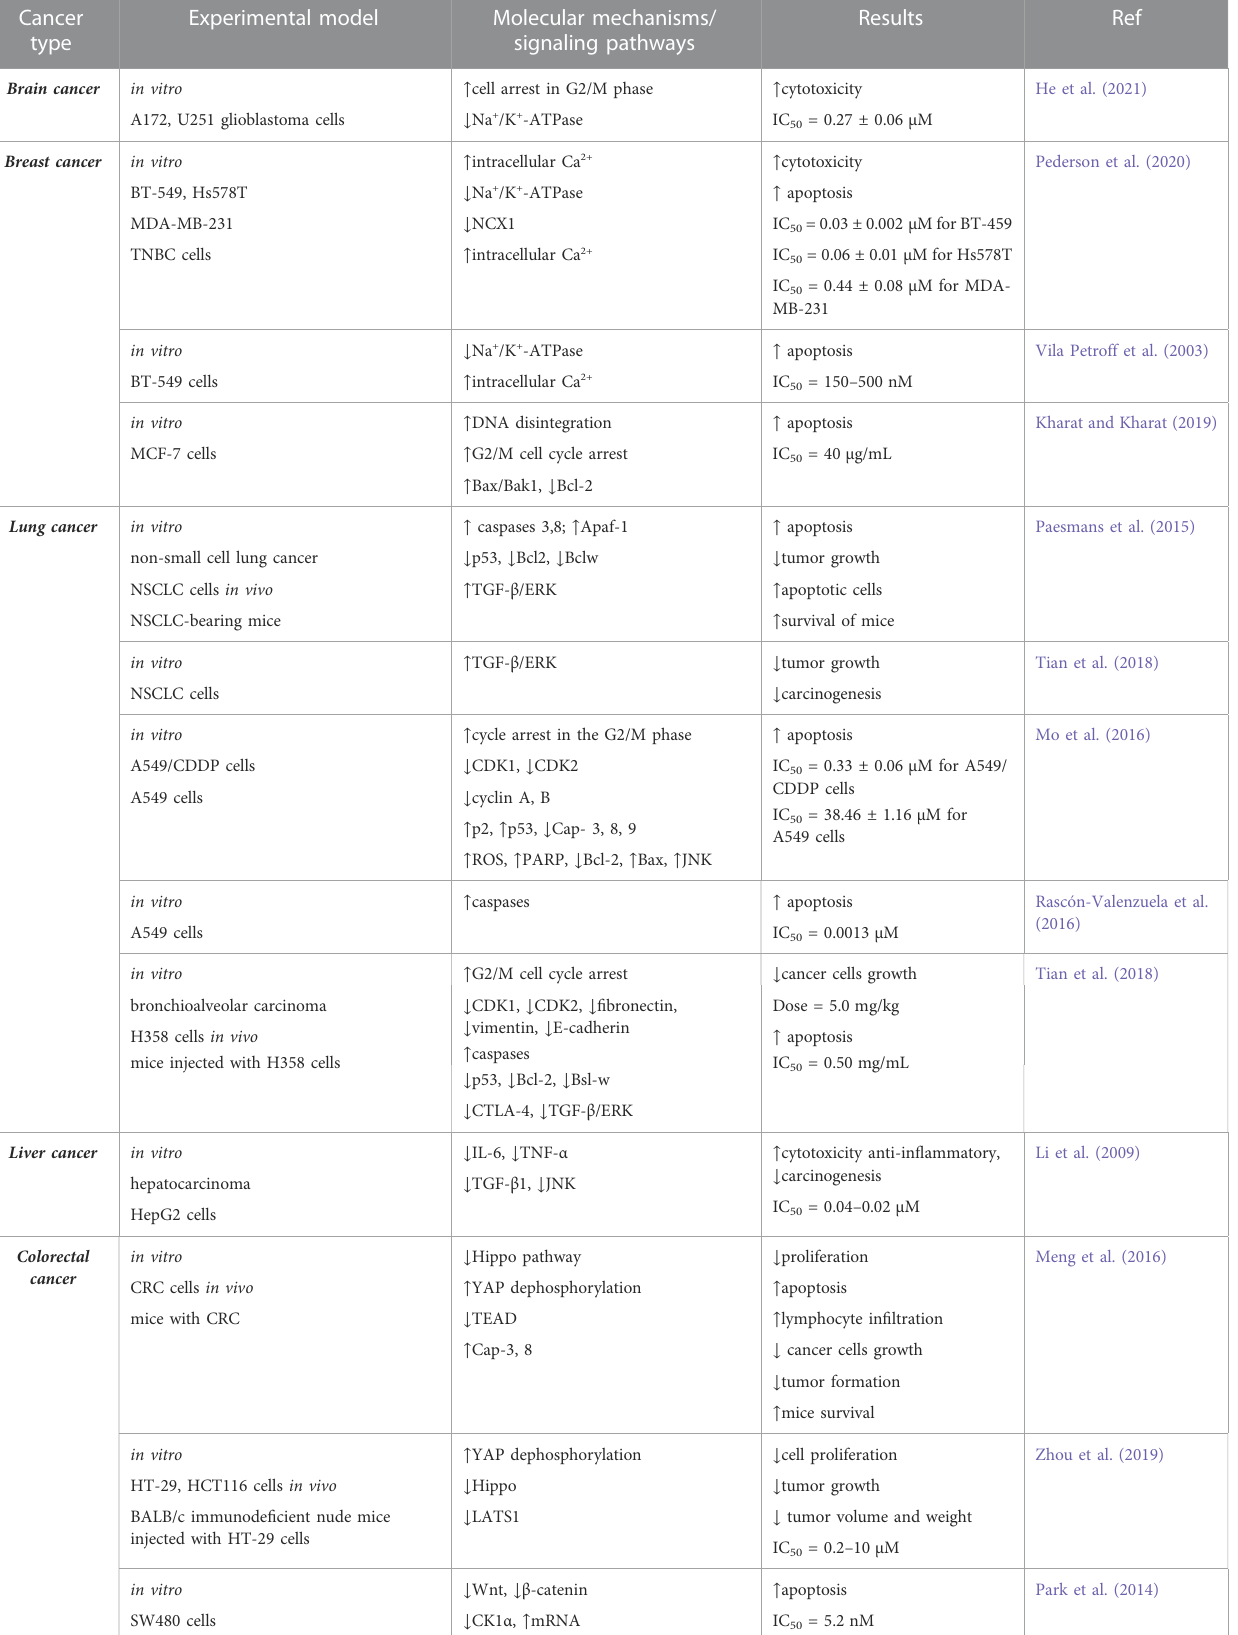
TABLE 1 Summarized data obtained from preclinical pharmacological studies regarding calotropin anticancer activity. Cancer